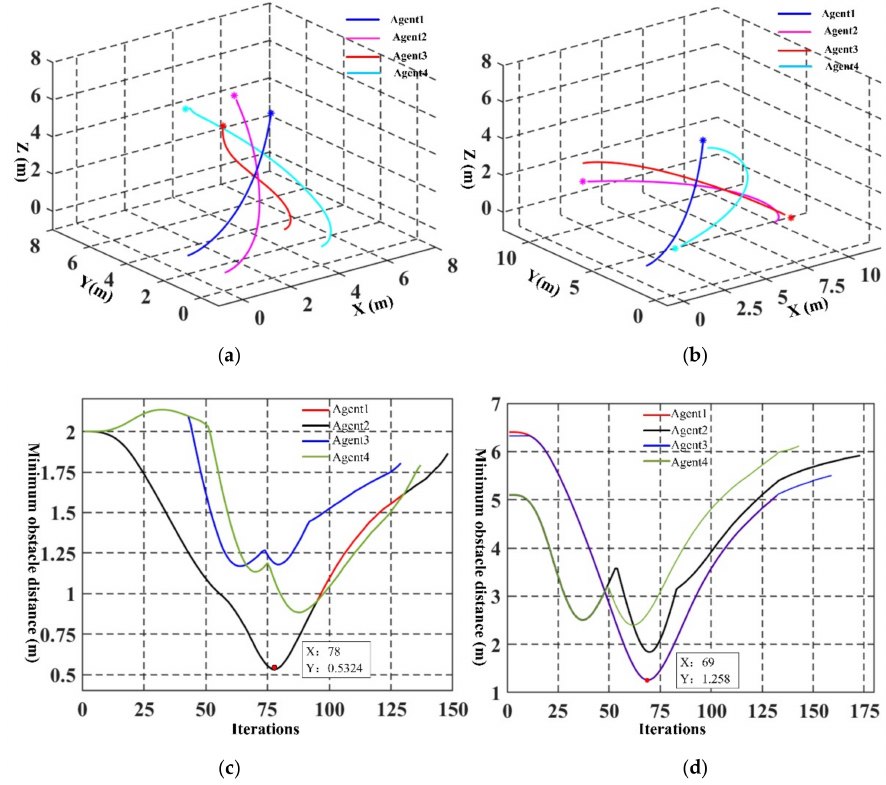
Figure 14. Dynamic obstacle avoidance: (( a ) four agents flying to the same plane; ( b ) four agents crossing each other; ( c ) the minimum obstacle distance between the agents at the same moment during the iterations in FFLSP scenario; ( d ) the minimum obstacle distance between the agents at the same moment during the iterations in FFCL